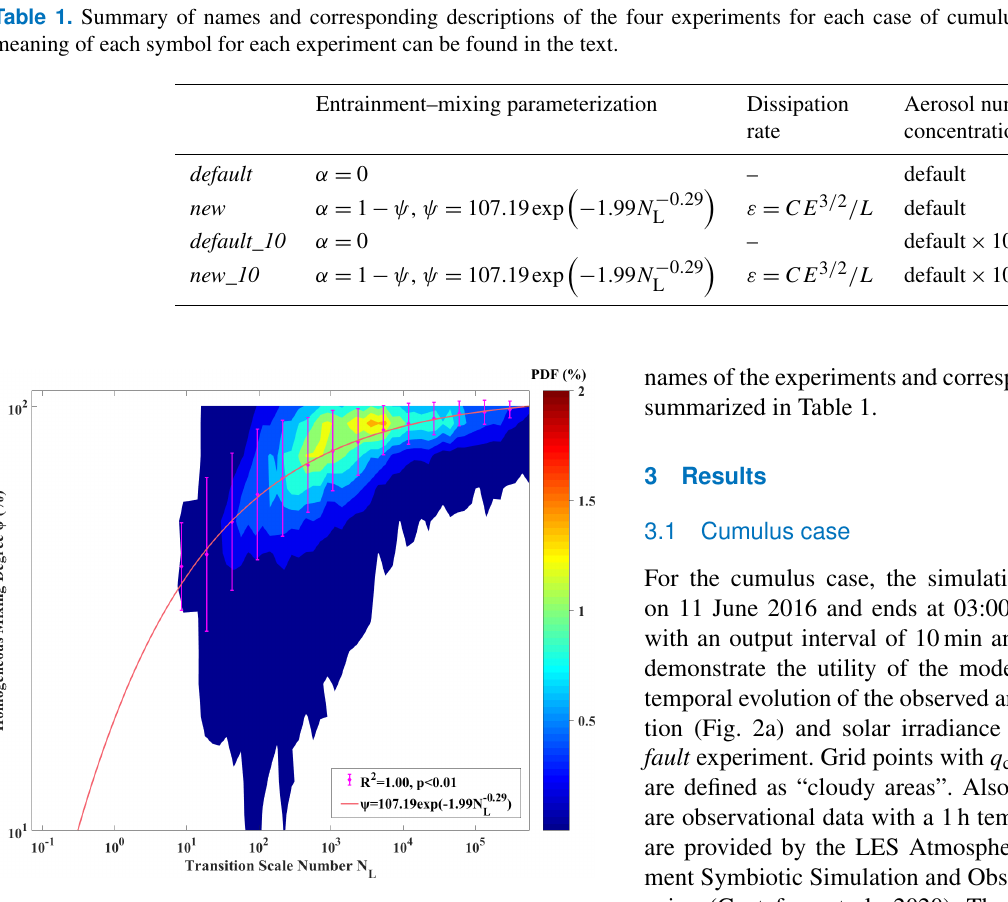
Figure 1. Parameterization of cloud entrainment–mixing mecha- nisms by relating homogeneous mixing degree ( ψ ) to transition scale number ( N L ) from EMPM. The contours represent the joint probability distribution function (PDF) of ψ vs. N L . The magenta dots and error bars are mean values and standard deviations of ψ in each N L bin, respectively. The mean values are fitted using a weighted least squares method with the number of data points in each N L bin as with the weight. The fitting equation, coefficient of determination ( R 2 ), and p values are also given. N L is calculated with the domain-averaged relative humidity after entrainment but before evaporation in the